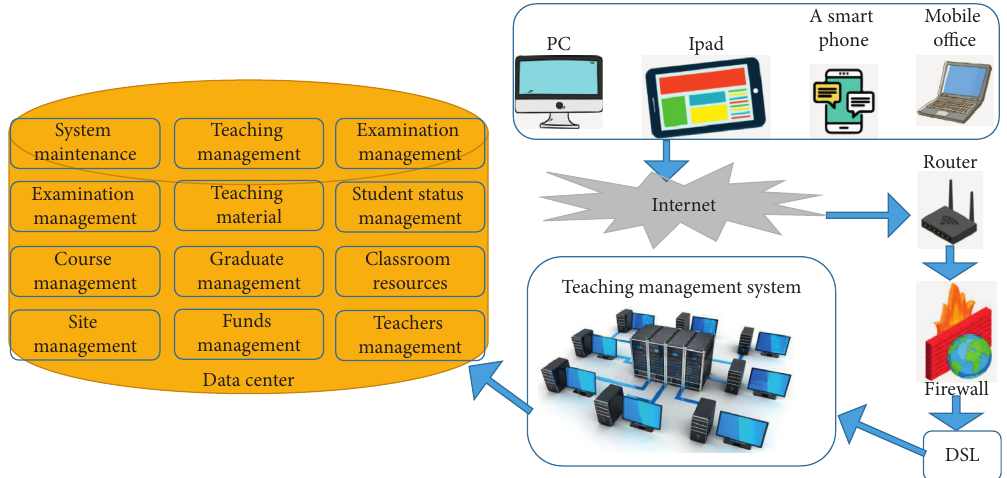
Figure 3: Network topology structure of teaching management